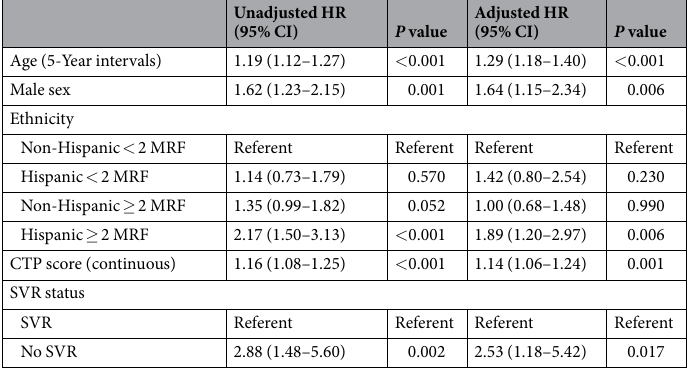
Table 3. Predictive factors for the development of HCC. Multiplicative interaction P -value: 0.44. Abbreviations: CTP, Child- Turcotte-Pugh; HCC, hepatocellular carcinoma; MRF, metabolic risk factor; SVR, sustained virologic